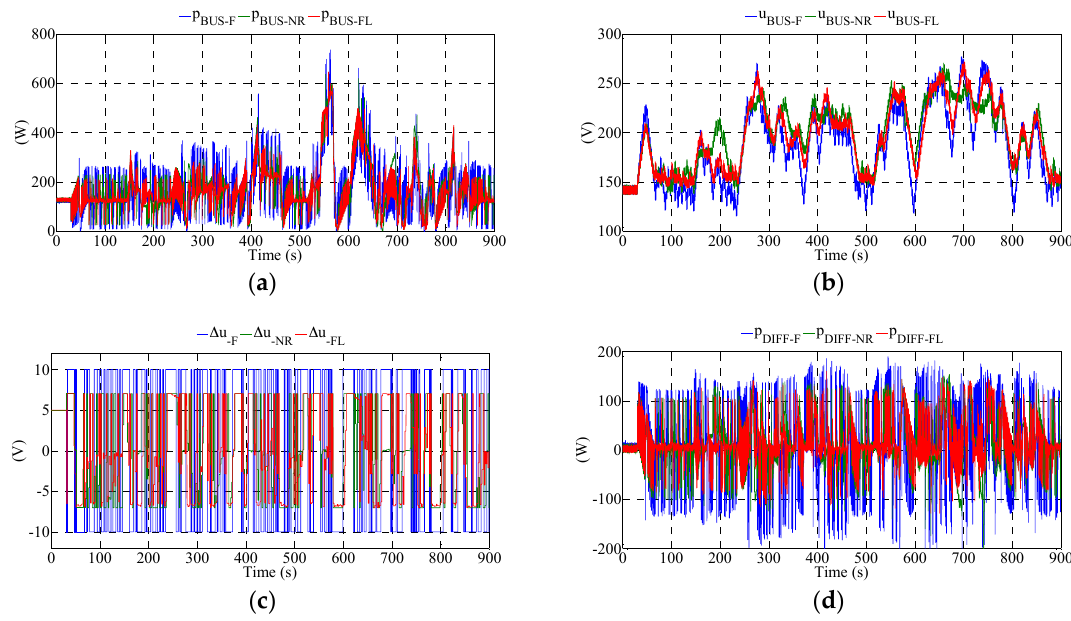
p ; ( b ) evaluation BUS